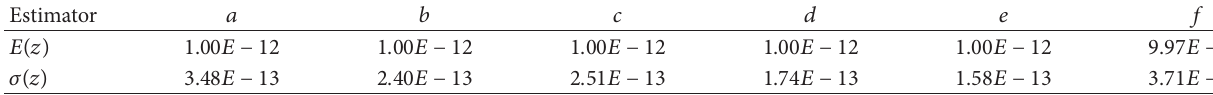
Table 12: Statistical property of the estimation result of six estimators.